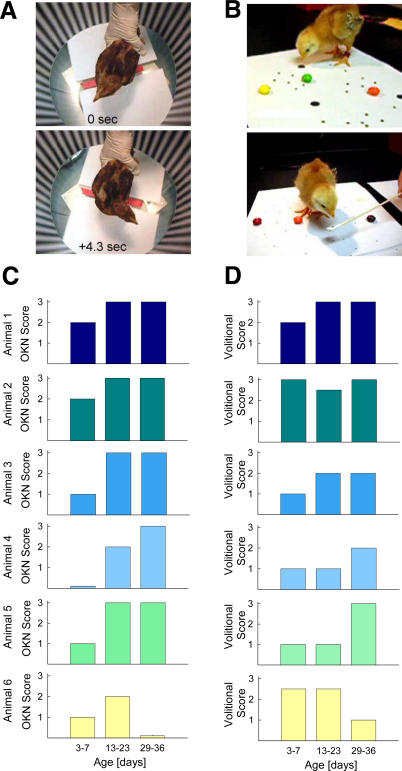
Optokinetic and Volitional Behavior Tests Indicate Treatment Efficacy(A) Optokinetic reflex (OKN) exhibited by 21-d-old, wild-type RIR chicken. Two frames of Video S1 (4.3 s between frames) are shown illustrating the head movement observed in birds in response to counterclockwise rotation of the 0.26-cycles·degree−1 (bar width = 1.25 cm) stimulus.(B) Volitional visual behavior exhibited by treated GUCY1*B animal 2 on day 7. Two frames of Video S4 are shown illustrating the animal's abilities to perceive and peck at objects within its visual field.(C and D) Graphic summaries of the behavioral test results for the six treated animals that exhibited sighted behavior. (C) Graphs showing the optokinetic scores (0–3) for the six treated animals as a function of age. (D) Graphs showing the volitional behavior scores (0–3) for the six treated animals as a function of age. The graphs are color coded by animal.